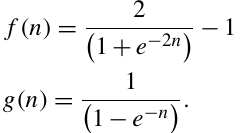
ticular, for a given landslide, all rain gauges within a